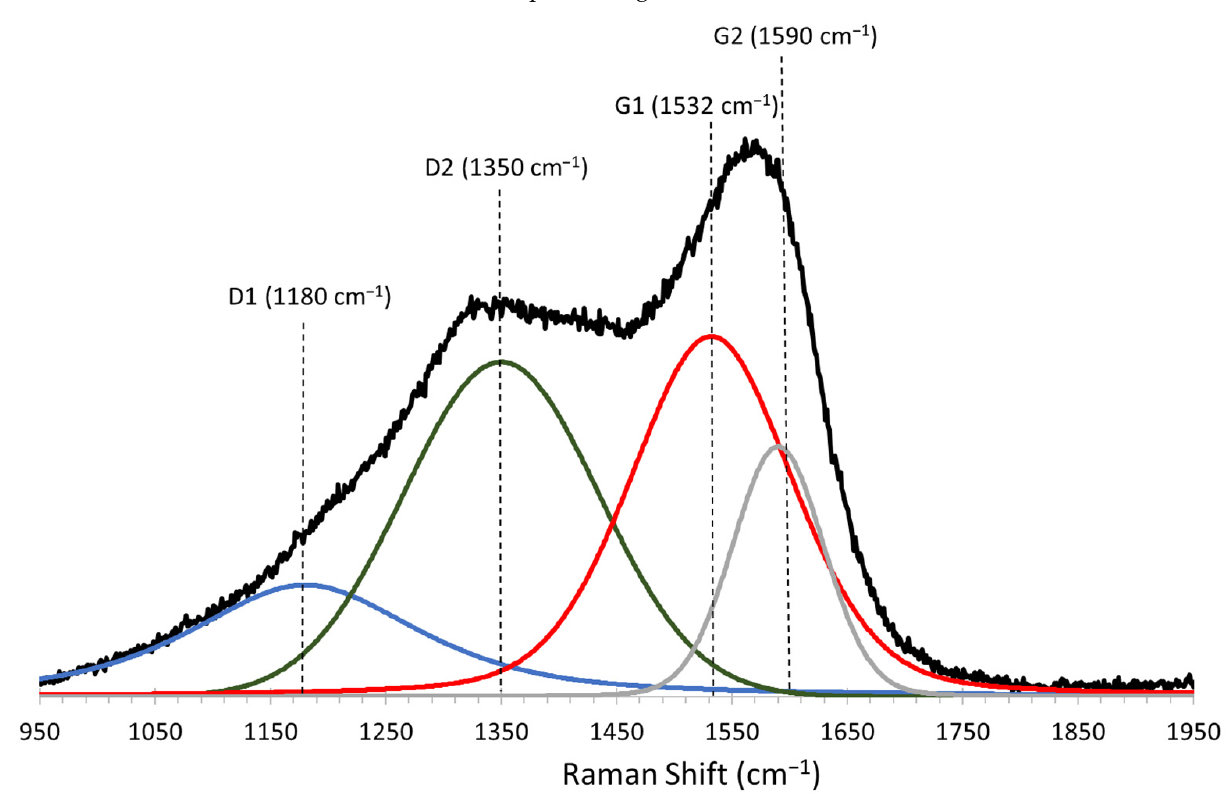
Figure 15. Raman spectrum of DLC coating manufactured by RF PACVD method- IG/IG = 1.08.